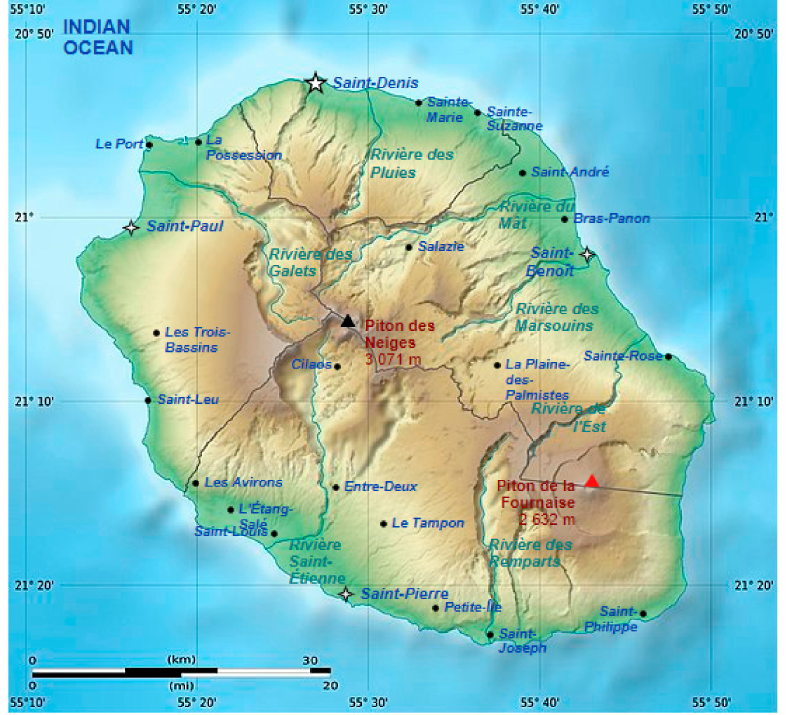
Figure 1. Reunion Island showcasing all the surrounding land areas. (The arrows Piton des Neiges (southwestern) and piton de la Fournaise (eastern side) represents shield volcanoes of the reunion island in the Indian